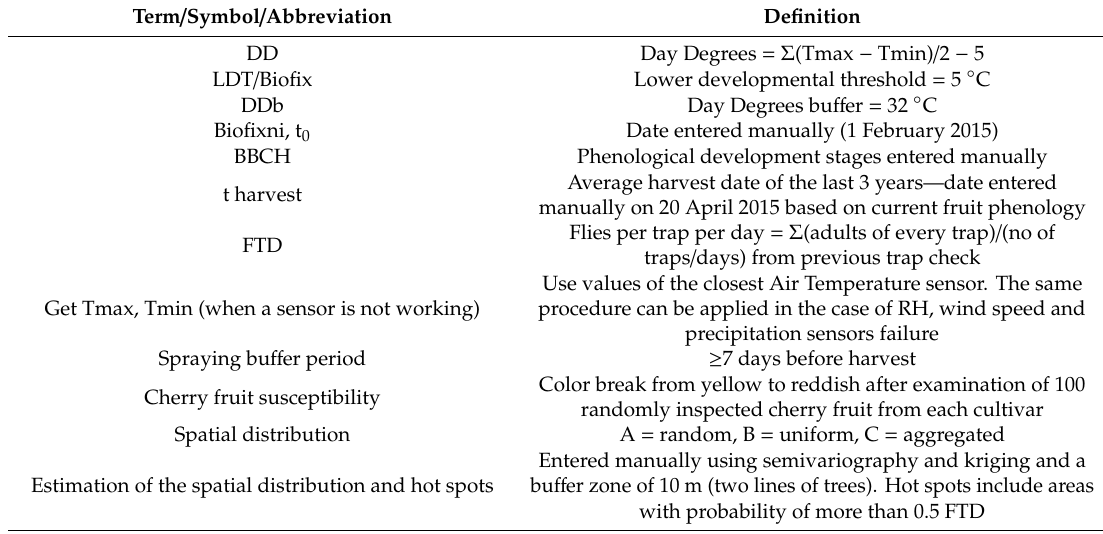
Table 2. Explanatory input list of terms and symbols used in the SDSS algorithm for the control of the European cherry fruit